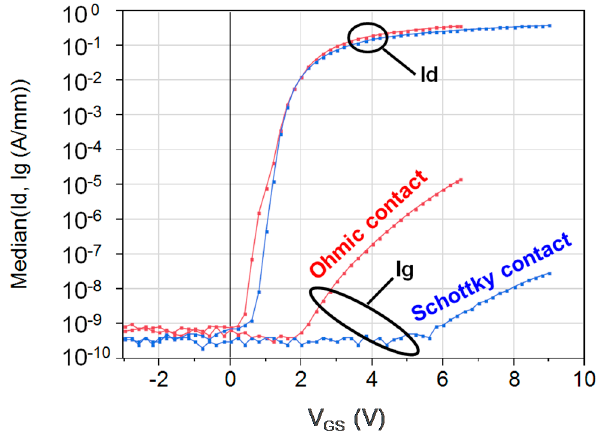
Figure 5. Transfer characteristics (drain and gate currents) for pGaN-gate transistors with Ni/Au-based ohmic gate contacts (red) and WSiN-based Schottky-type contacts (blue). Wafer medians from 36 devices each are shown. V DS = 10 V.